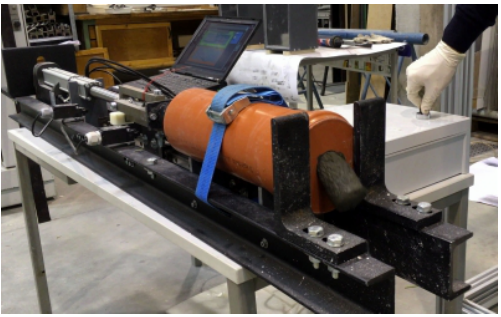
Figure 6. Ram-extrusion device in operation, here Mixture B is